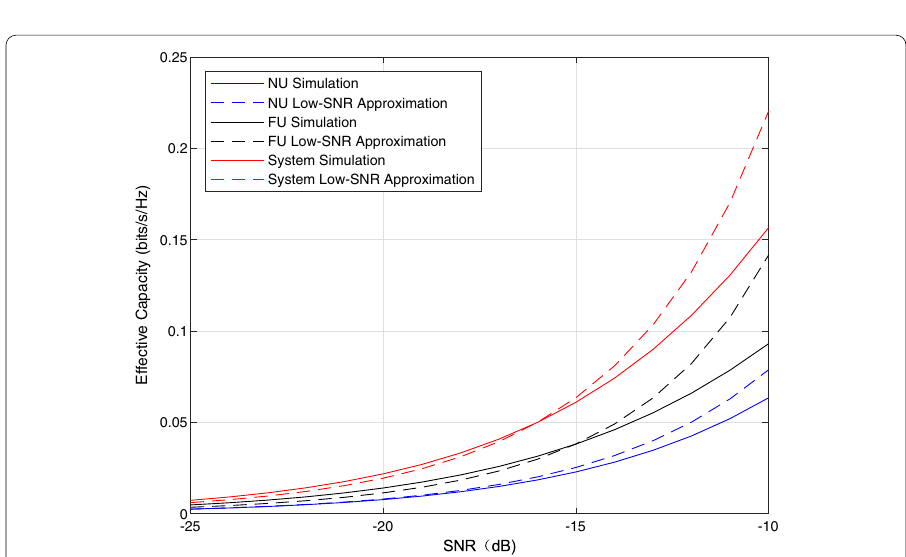
Fig. 6 EC approximation in low-SNR regions with N